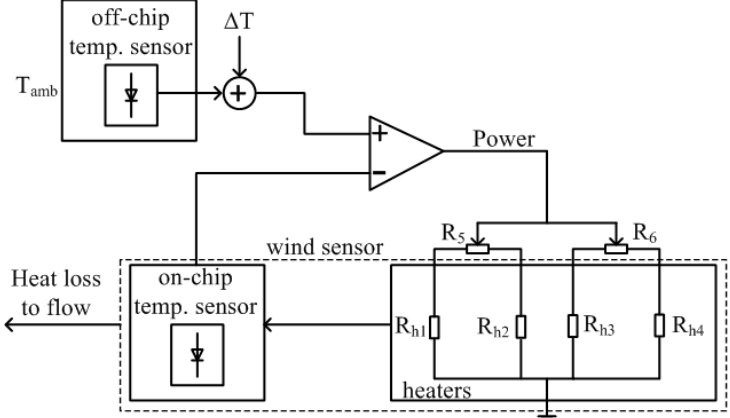
Figure 8. Scheme of the control circuit used to maintain a constant temperature difference between the sensor and the airflow.